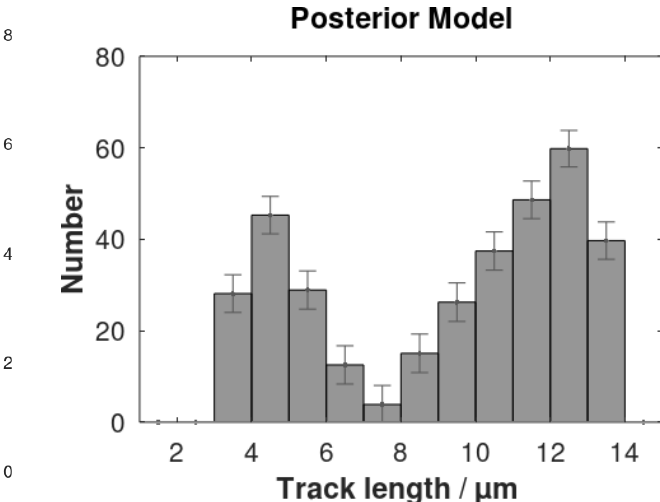
Figure E1. A 3D histogram of track lengths versus angles derived by combining two annealing experiments (Barbarand et al., 2003). The greyscale range denotes the number of tracks in each bin.